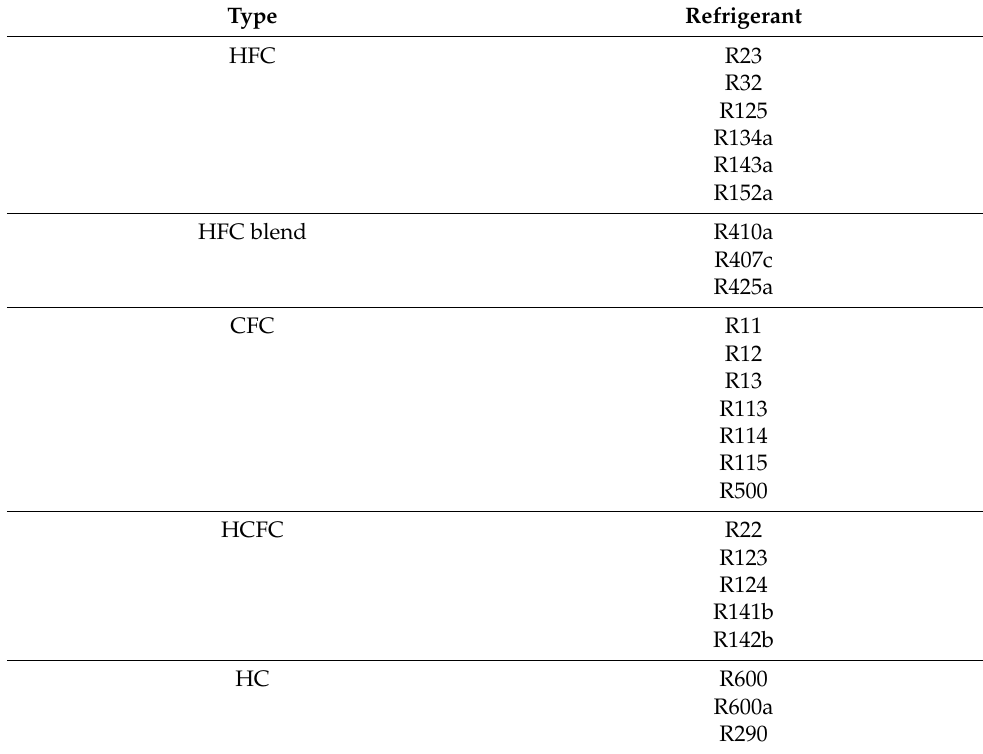
Table 1. List of main refrigerants